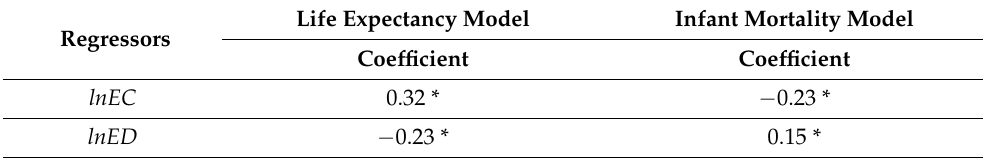
Table 13. Long-Run Estimates Based on DOLS for Health Outcome